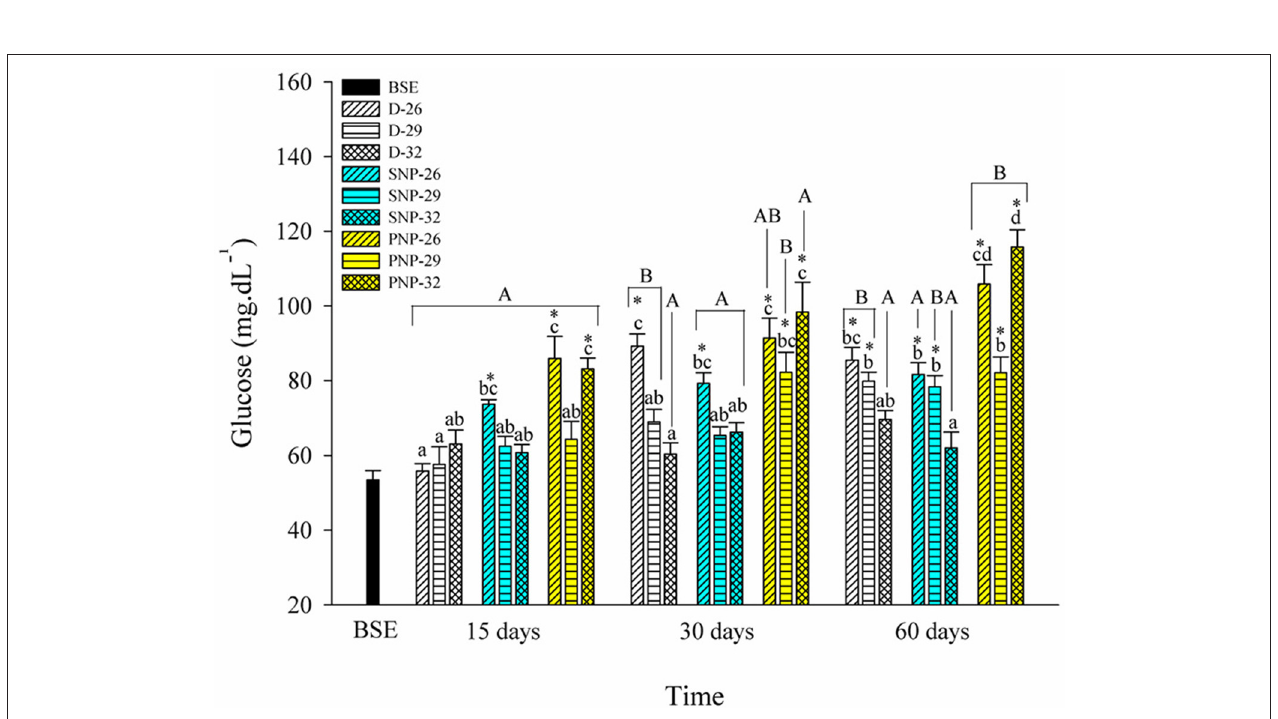
FIGURE 4 | Plasma glucose of juveniles of Colossoma macropomum under controlled conditions of photoperiod and temperature. Data are expressed as mean ± SEM ( N = 3). The different capital letters indicate significant differences in the same treatments over the experimental period ( p < 0.05), while the lowercase letters indicate significant differences in the different treatments in the same experimental period ( p < 0.05). * Indicate differences of the treatments in relation to BSE group.